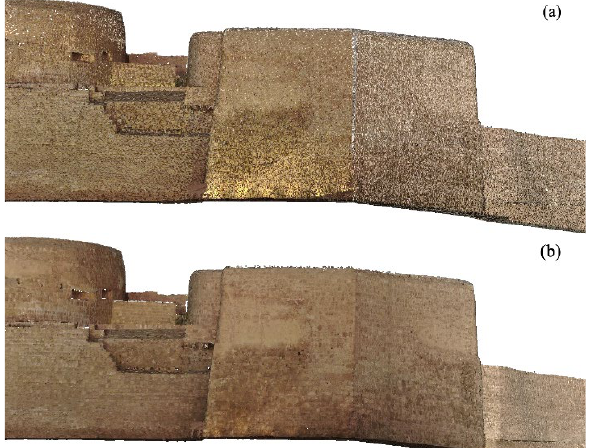
Figure 15. LiDAR point optimisation (filtering and radiometric balancing). (a) LiDAR point cloud before the optimisation; (b) LiDAR point cloud after the optimisation.